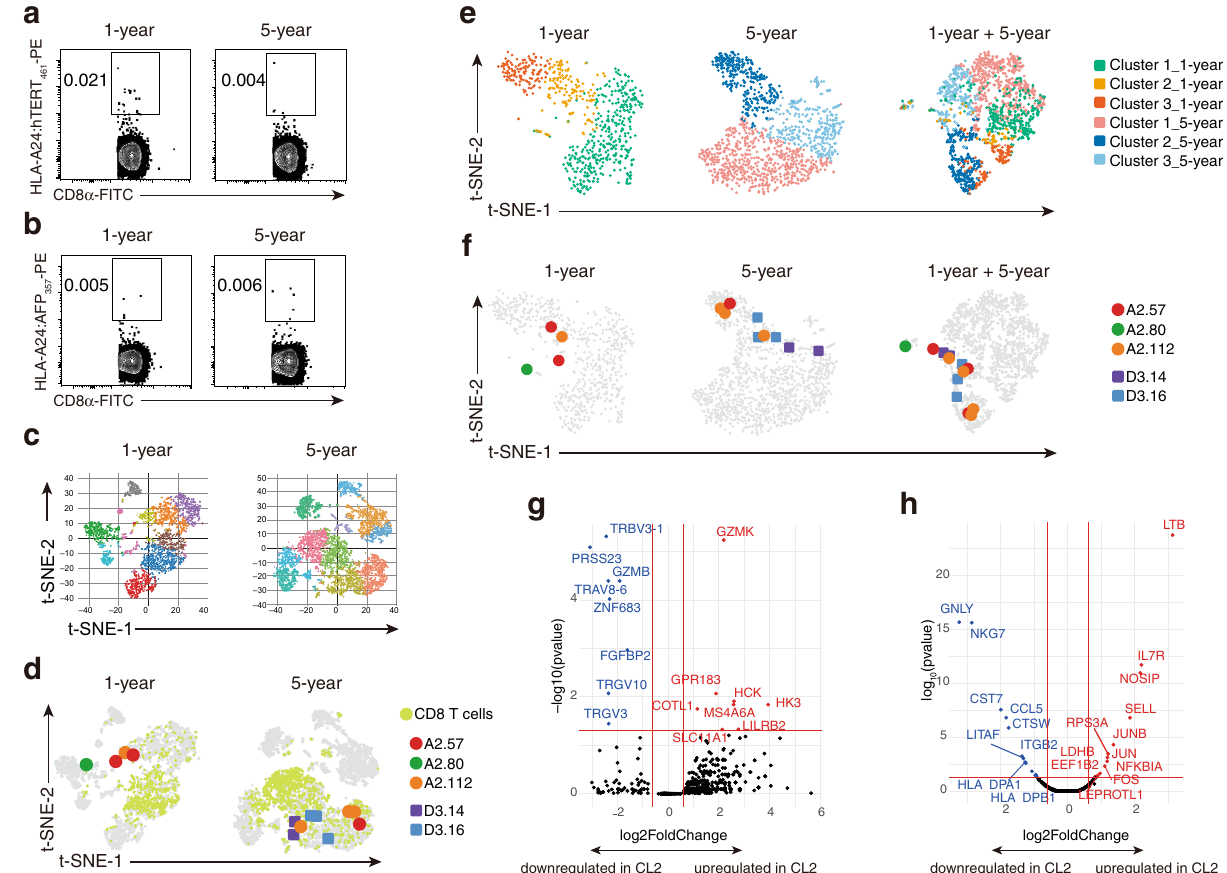
Fig. 5 Transcriptome landscape of peptide-speci fi c T cells. Unstimulated PBMCs of patient A2 at each timepoint were stained with HLA-A24:hTERT 461 tetramer along with an anti-CD8 α antibody and 7-AAD. Flow plots are presented with frequencies (%) of tetramer + cells among CD8 + cells ( a ). Unstimulated PBMCs of patient D3 at each timepoint were stained with HLA-A24:AFP 357 tetramer along with the anti-CD8 α antibody and 7-AAD. Flow plots are presented with frequencies (%) of tetramer + cells among CD8 + cells ( b ). To proceed with such small frequencies of tetramer + cells, the 1-year tetramer + cells were enriched and mixed to prepare the 1-year enriched mixture. A 5-year enriched sample was also prepared. These samples were applied to the scRNA-seq analysis pipeline and the obtained transcriptome matrixes are presented in the t-SNE plots with clustering (see Supplementary Figure 3) ( c ). Single-cell VDJ-seq data were imported into the scRNAseq in accordance with their UMIs. Three hTERT-speci fi c TCR sequences (A2.112, A2.80, and A2.57) and two AFP-speci fi c TCR sequences (D3.14 and D3.16) were retrieved and visualized on the t-SNE plots. Cells that met the criteria of CD3E log2 fold change >0 and CD8A log2 fold change >0 are highlighted in light green ( d ). Cells that met the criteria of CD3E log2 fold change >0 and CD8A log2 fold change >0 were extracted and underwent the t-SNE dimension reduction followed by the k-means clustering again. Each plot generated three clusters (left and middle). The 1-year data and 5-year data were combined and subject to the t-SNE dimension reduction with the cluster marks held over (right) ( e ). Peptide-speci fi c T cells were overlayed on the new plots ( f ). Differentially expressed genes were extracted by comparing the newly generated cluster (CL) 2 with the others of the 1-year t-SNE and then shown on a volcano plot ( g ). Differentially expressed genes were extracted by comparing newly generated cluster 2 with the others of the 5-year t-SNE and then shown on a volcano plot ( h ). Source data are provided as a Source Data fi